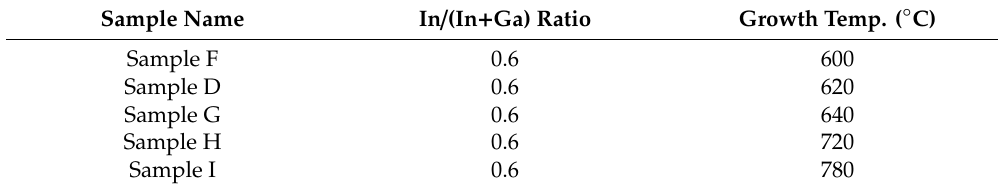
Table 2. The growth parameters for sample series II as a function of growth